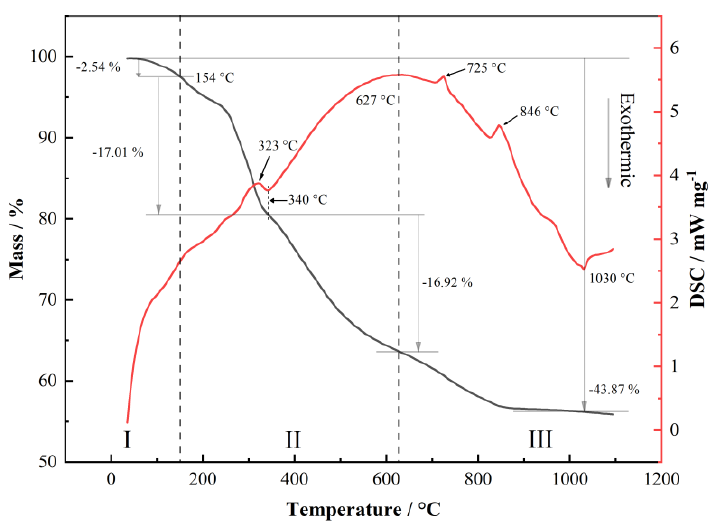
Figure 2. TG-DSC curves of raw materials at a heating rate of 10 K/min in air atmosphere. Combined with the basic principle of high-temperature solid-state reactions and the property of the materials, it is considered that the sintering process of the raw materials is mainly divided into three steps, namely, (I) dehydration, (II) the decomposition of dehydrated intermediate and (III) the generation of the target product. Step (I) occurs in the range of room temperature to 154 °C. The first mass loss of 2.54% can be attributed to the removal of adsorbed water from the carbonate mixture and the dehydration of crystallized water in CoCO 3 · xH 2 O. Step (II) occurs in the temperature range of 154~627 °C, in which the decomposition reactions of NiCO 3 , MnCO 3 and CoCO 3 are completed and the mass loss is caused by the decomposition of dehydrated intermediate. The endothermic decomposed [19–22]. According to the TG curve, the actual mass loss (17.01%) is higher